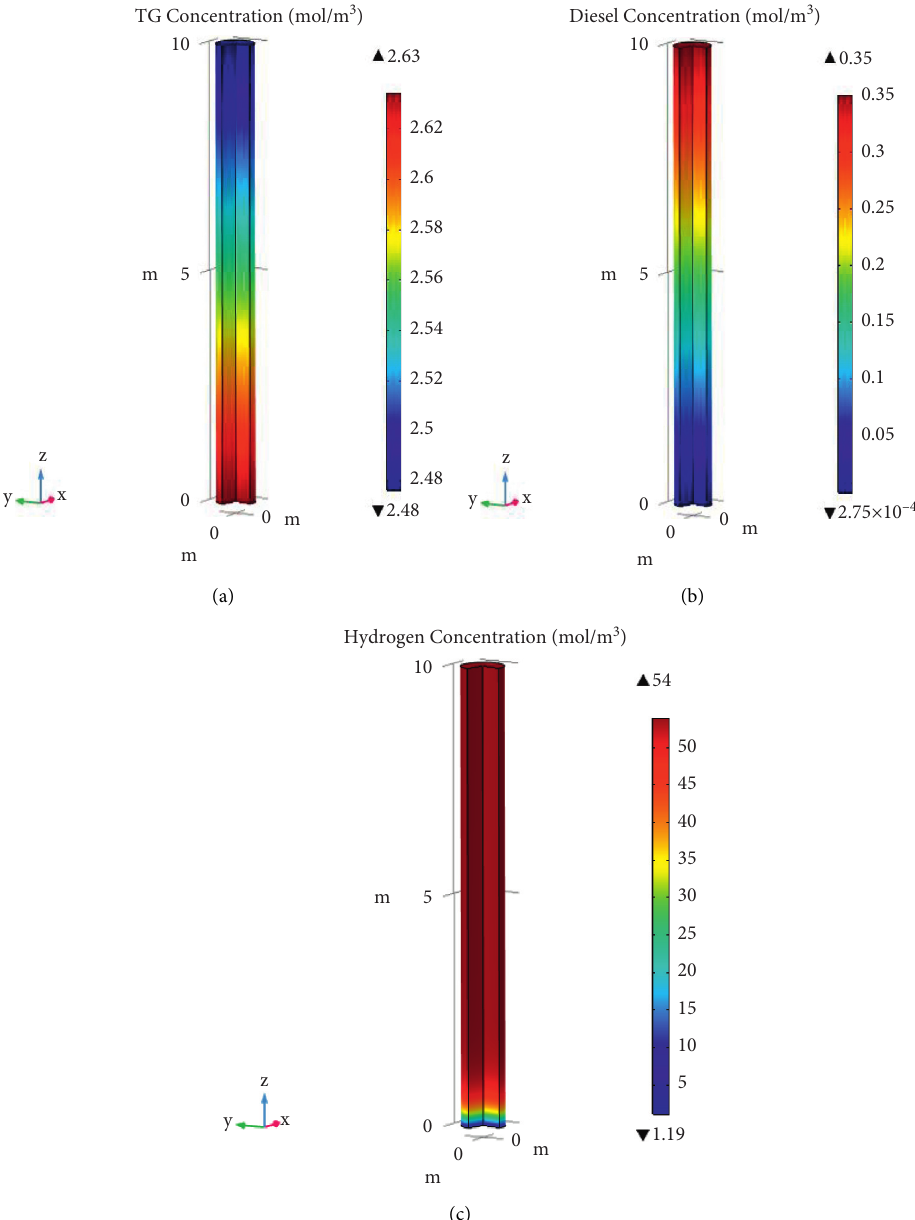
Figure 5: Concentration profiles of (a) triglyceride, (b) diesel, and (c) hydrogen.